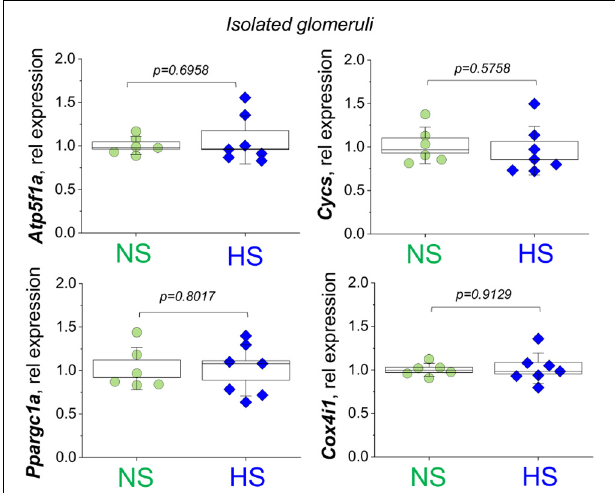
FIGURE 3 | Relative expression of the Atp5f1a , Cycs , Ppargc1a , and Cox4i1 genes assessed in the fraction of the glomeruli isolated from normal salt (NS) and high salt (HS) diet fed Dahl SS rats. Each point on the graph is a sample from a separate animal. P -values were obtained with t -tests, assuming unequal